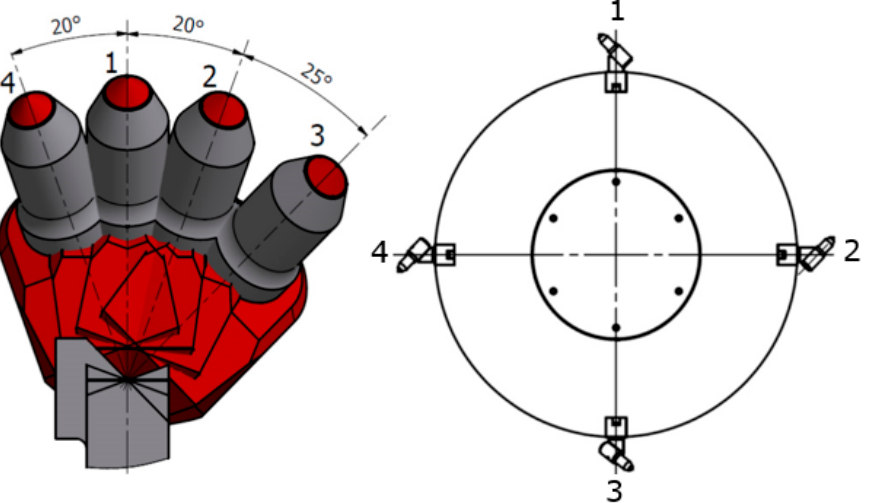
Figure 10. Diagram of the applied pick system with the marking of picks’ numbers [21,28,29,37].